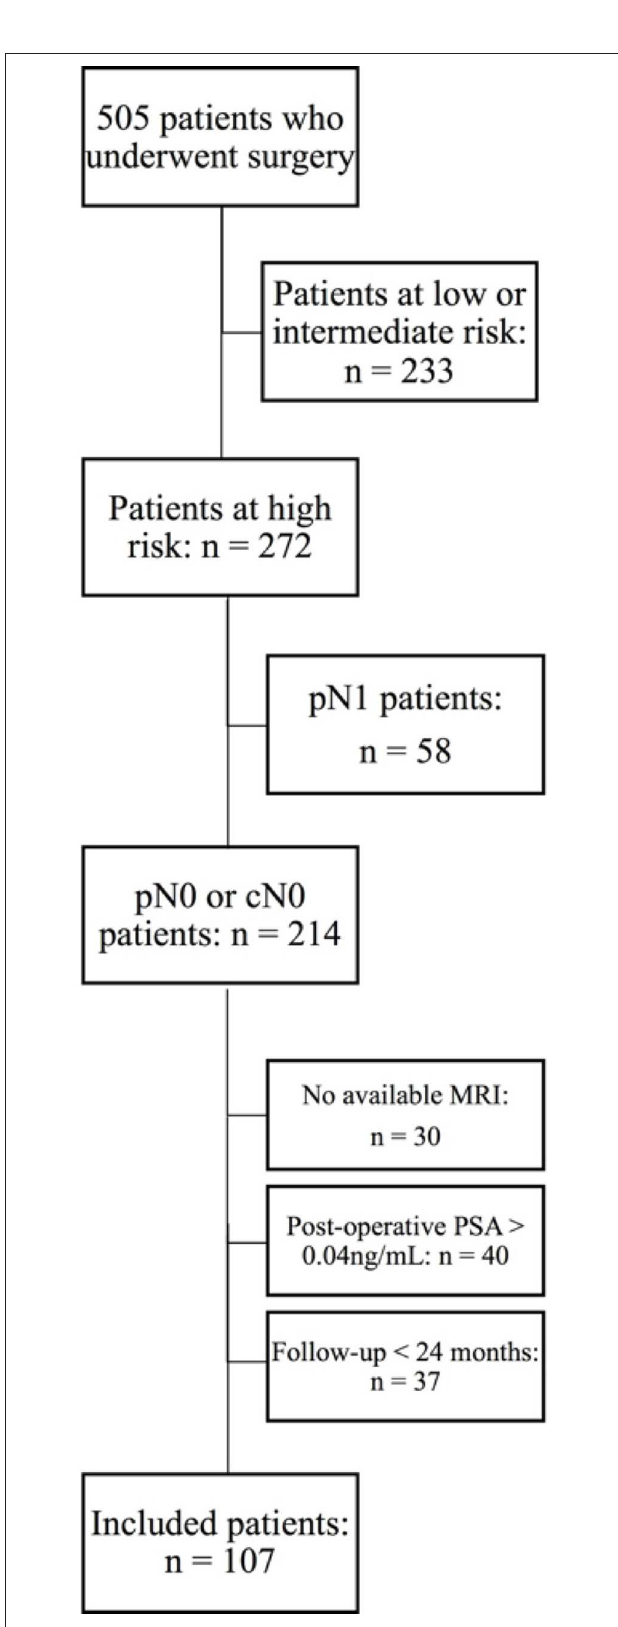
FIGURE 1 | Flowchart of the patients selection.